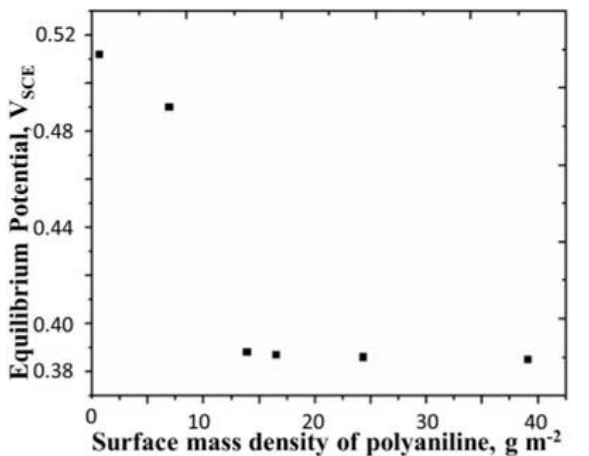
Figure 3. Equilibrium potential of polyaniline film versus surface mass density of polyaniline. Concentration of H 2 SO 4 = 0.5 M, temperature = 25 °C. All potentials are reported with respect to SCE.